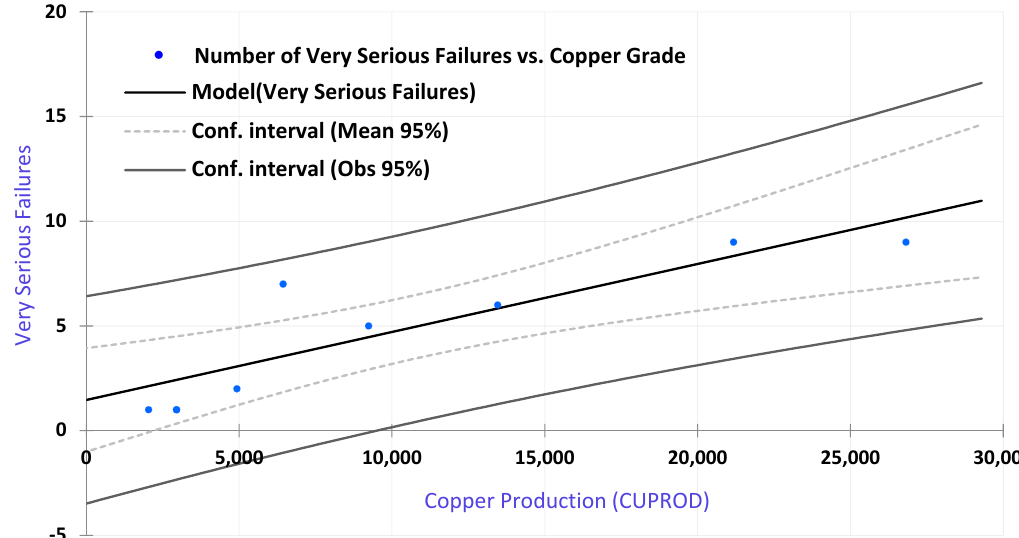
Figure 8. Regression of Very Serious Failures by copper production (R 2 = 0.764).